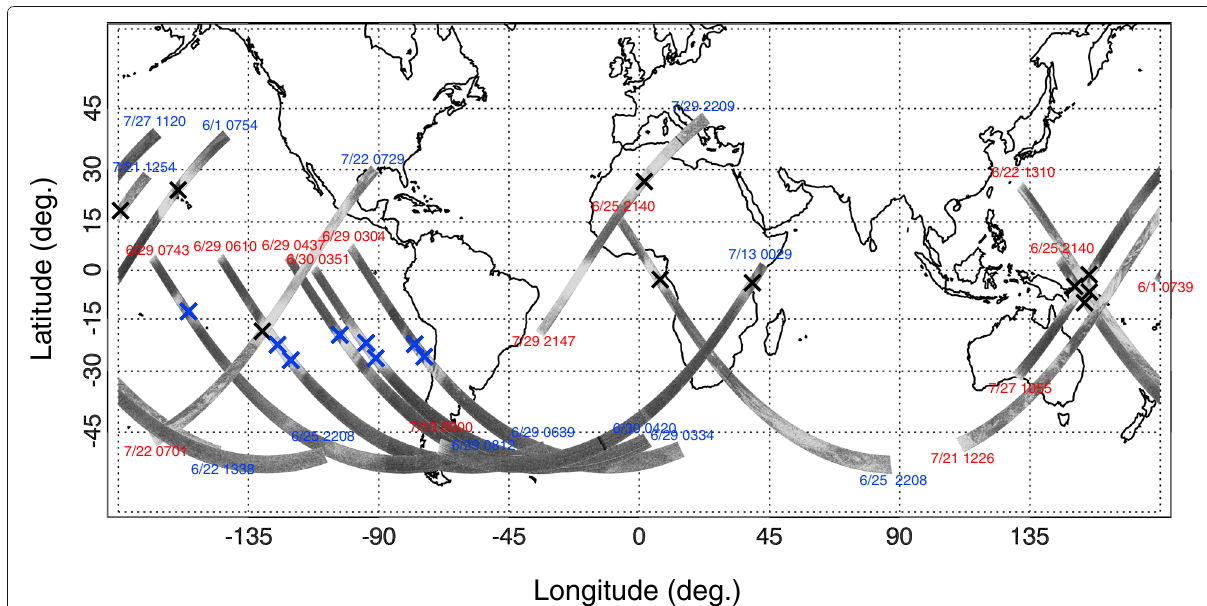
Fig. 4 The EPB events occurring between June and July 2013, and the associated airglow images along the ISS-tracks. The locations of EPBs are shown by crosses. Blue crosses show the events on 29 June 2013. The red and blue numbers show the start and end times of the observation of each track, respectively